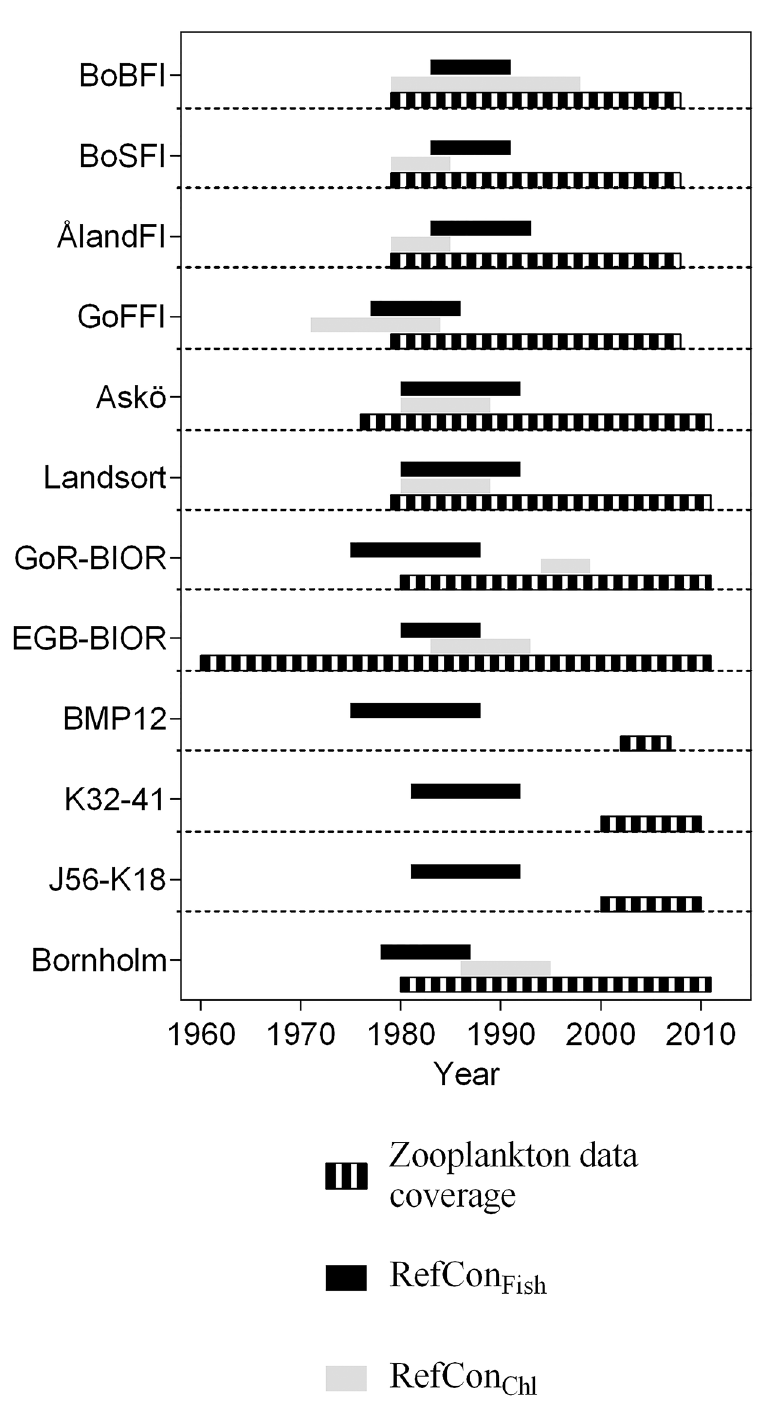
Fig 2. Time coverage for zooplankton data and reference periods based on the existing EQR for Chlorophyll a (RefCon Chl ) and fish body condition (RefCon Fish ) for each dataset. See Table 1 for details.